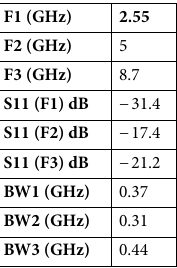
Table 2. Electrical properties of Antenna2